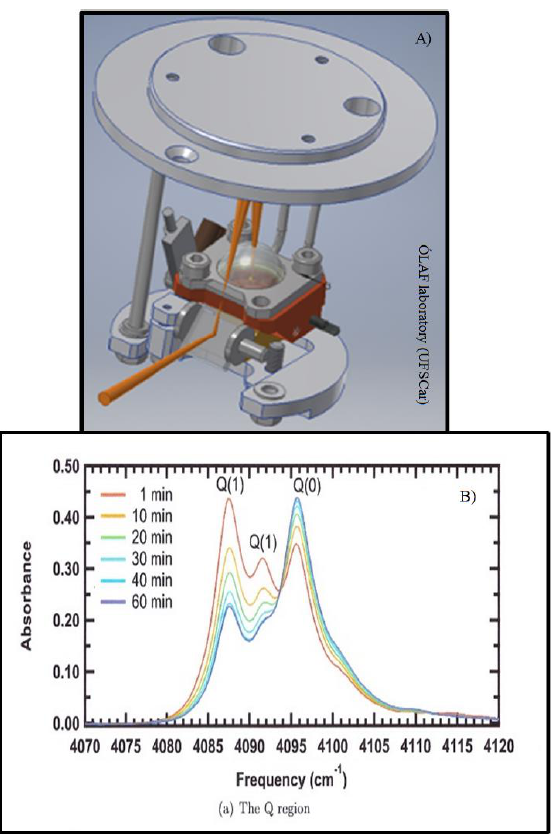
Fig. 14. Infrared spectroscopy in nanocages: A) opto- mechanical detail from the experimental setup; B) infrared intensity lines during the o-p conversion in the metal-organic framework (MOF) [72-77]. Ortho and Para Hydrogen IR Absorption Lines Time Evolution in Molecular Organic Frameworks. Ortho (red) and Para (blue) lines of Hydrogen adsorbed on MOF 74 sites (1). (The legend gives time after loading H 2 into the sample chamber). Reproduced with permission from Burkholder, B., “Catalysis of Conversio n Between the Spin Isomers of H 2 by MOF- 74”, Oberlin College,